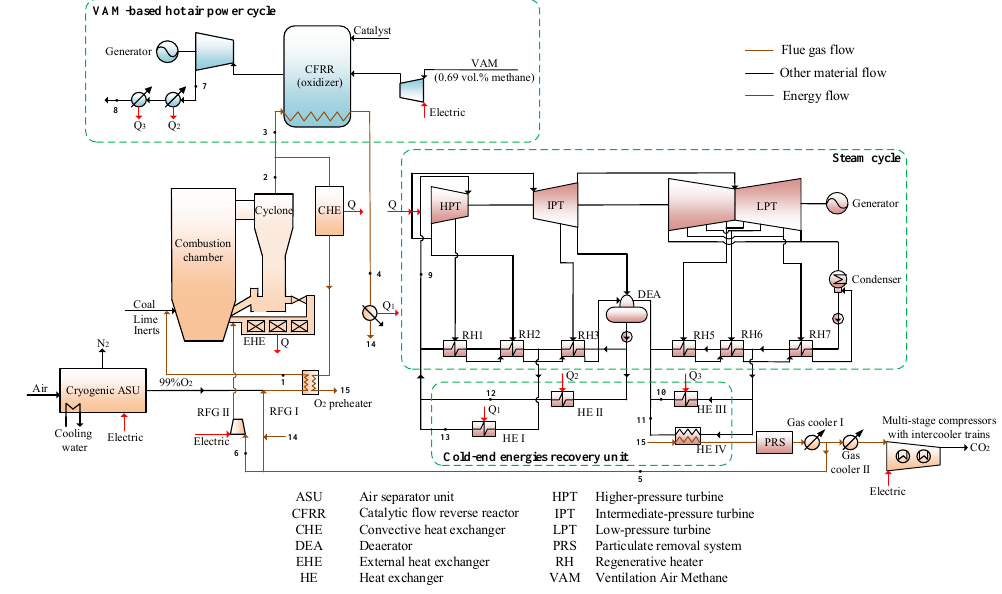
Figure 1. Schematic of the proposed system.